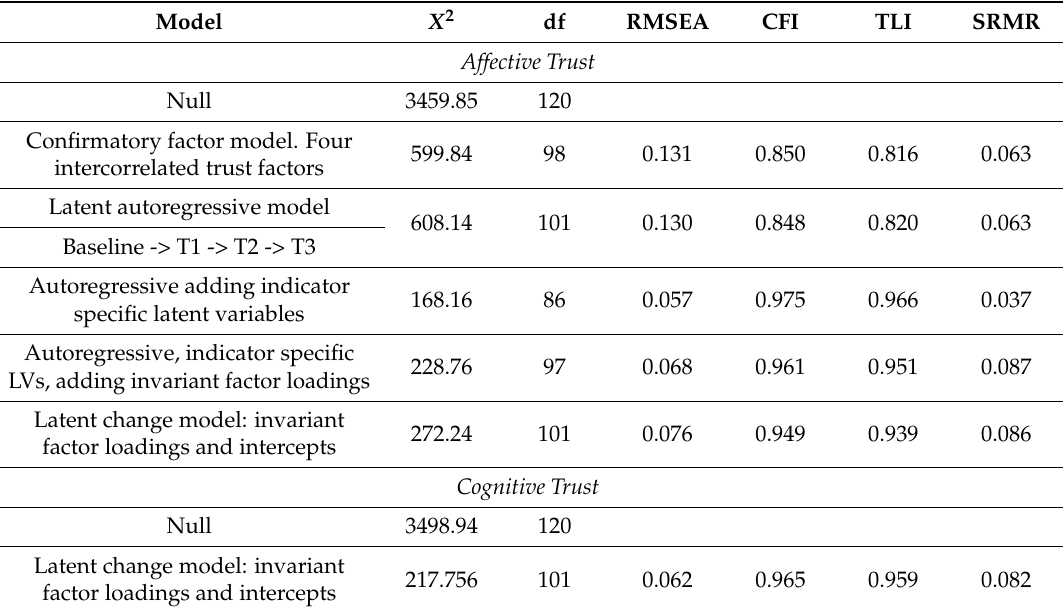
Table 1. Latent state analysis of